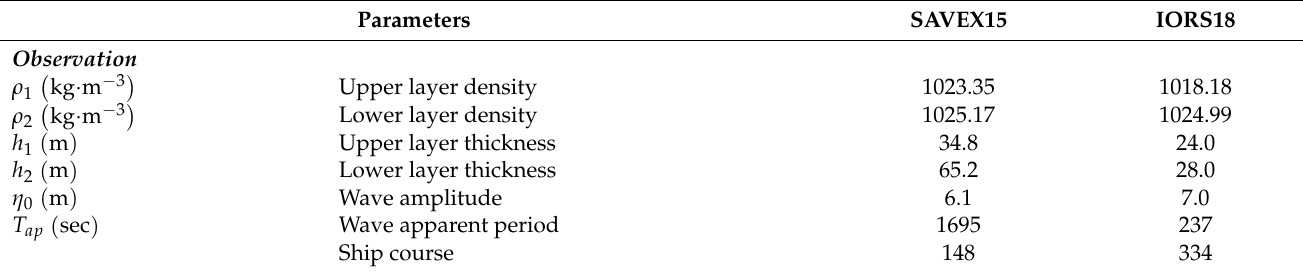
Table 1. Nonlinear internal wave parameters for the two cases observed, with calculated and estimated values. Parameters SAVEX15 Observation